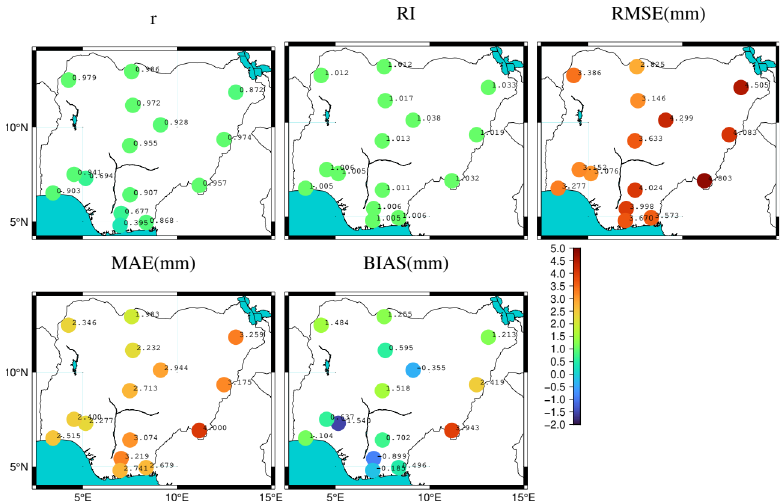
Figure 9. Statistical plot of sub-daily agreement of PWV from ERA5 and GNSS from 2012–2013